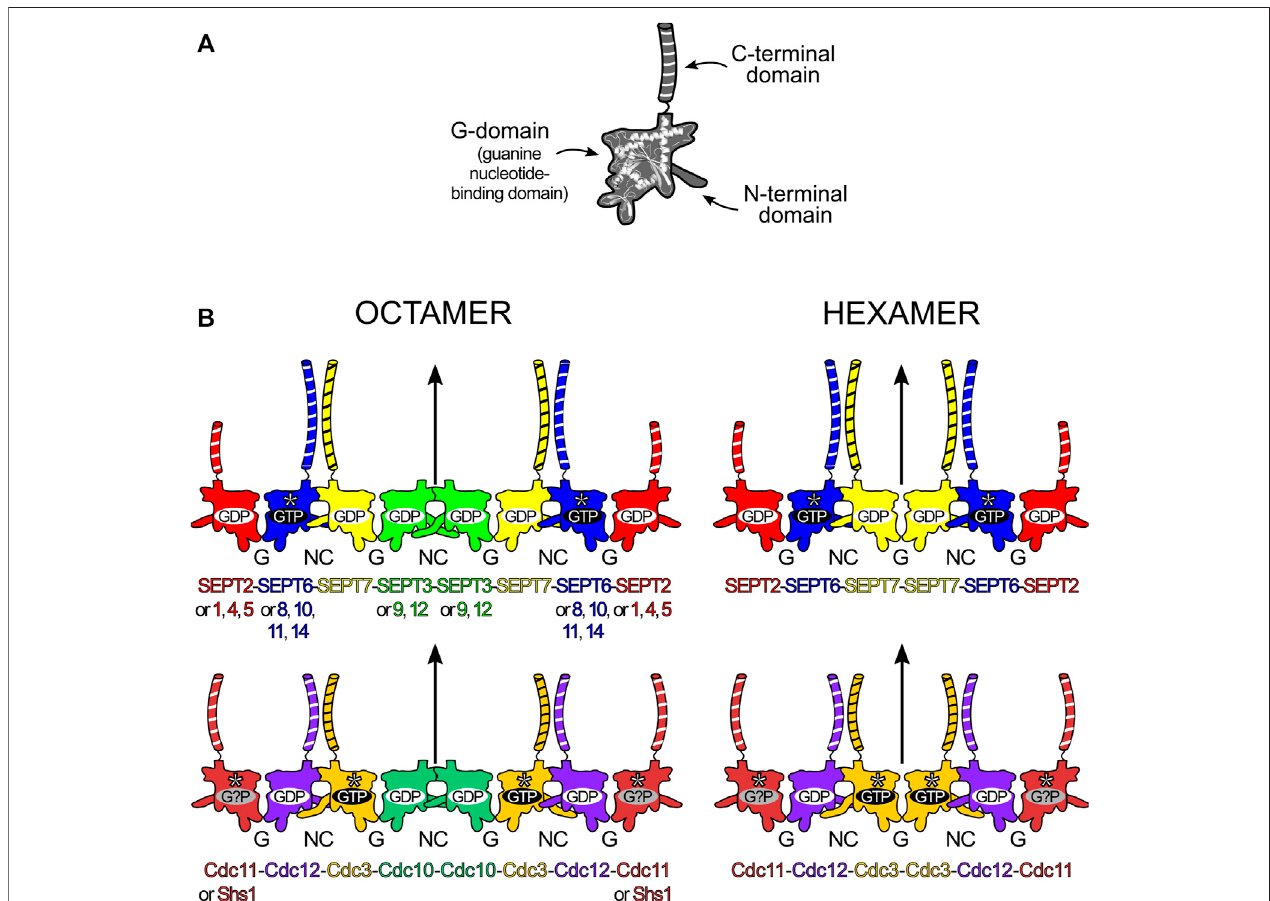
FIGURE 1 | Structural elements and core particle composition of septin fi laments. (A) The septin structure is divided into three main domains: the N-terminal domain, the guanine nucleotide-binding domain (or G-domain) and the C-terminal domain (depicted with black and white stripes). (B) Octameric (left) and hexameric (right) core particles in human (top) and baker ’ s yeast ( Saccharomyces cerevisiae , bottom ). In human septins, replacements according to “ Kinoshita ’ s rule ” are depicted on the octamer. Straight arrows represent the twofold rotational symmetry (diad) axis at the center of the core particle. The yeast hexameric oligomer presentedisthatformed intheabsenceofCdc10(Cdc10-less oligomer). SEPT6-groupmembers (blue), Cdc3andCdc11arecatalytically inactiveand donothydrolyse GTP(asterisks).Cdc11seemstobindonlycytosolicGDP(althoughspeculatively)andShs1canalsocapoctamers,replacingCdc11.ThelongN-domainsinSEPT3and Cdc3 are also